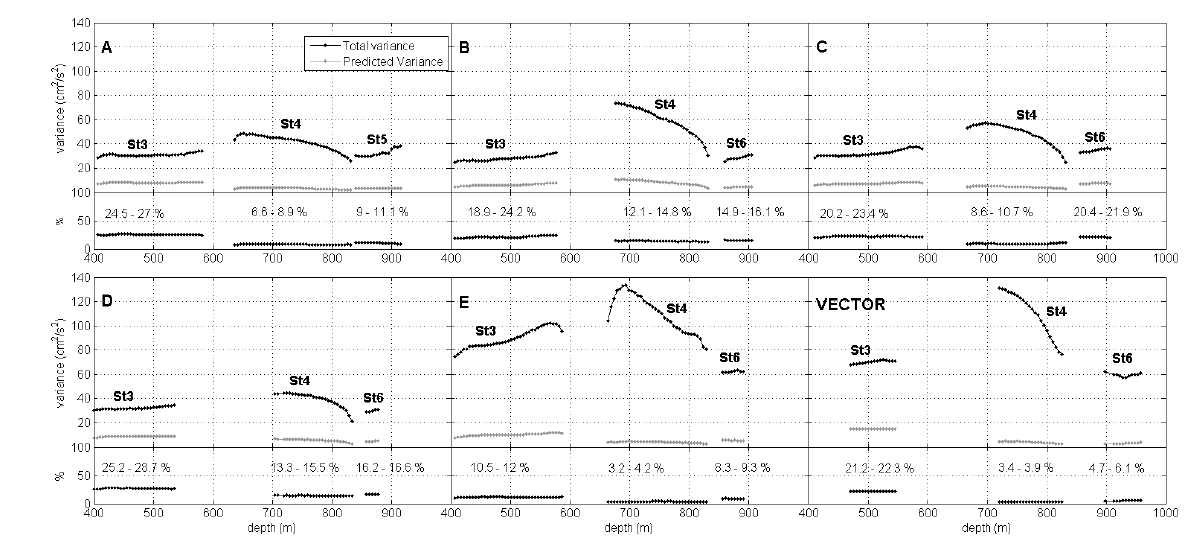
Fig. 8. Total variance (black dots), predicted variance (grey dots) and its contribution to the total one (%) as a function of depth. The predicted variance was calculated considering all the resolved tidal constituents (35) along the Otranto section, from MATER (periods A, B, C, D and E) and VECTOR data. Note that during period A, to avoid overlapping, the variances at St5 are plotted adding 60m to the true depth.